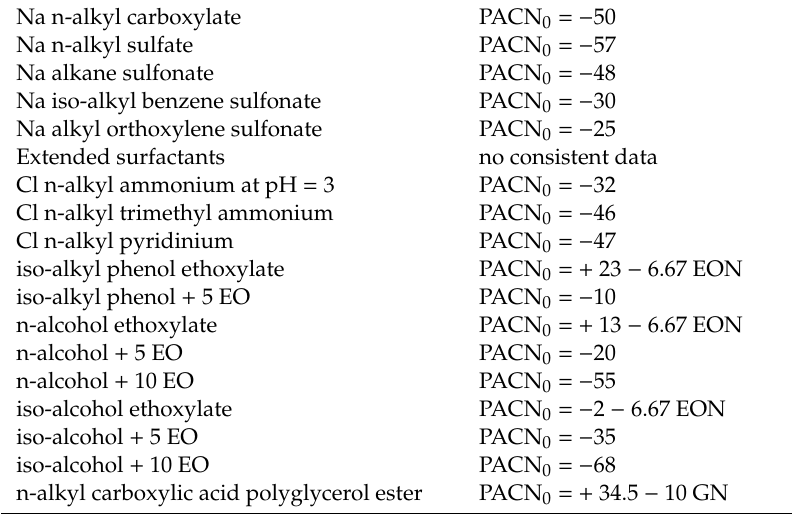
Table 1. Surfactant head contribution parameter PACN 0 expressed in ACN units as in Equation (16). Na n-alkyl carboxylate PACN 0 = − 50 Na n-alkyl sulfate PACN 0 = − 57 Na alkane sulfonate PACN 0 = −